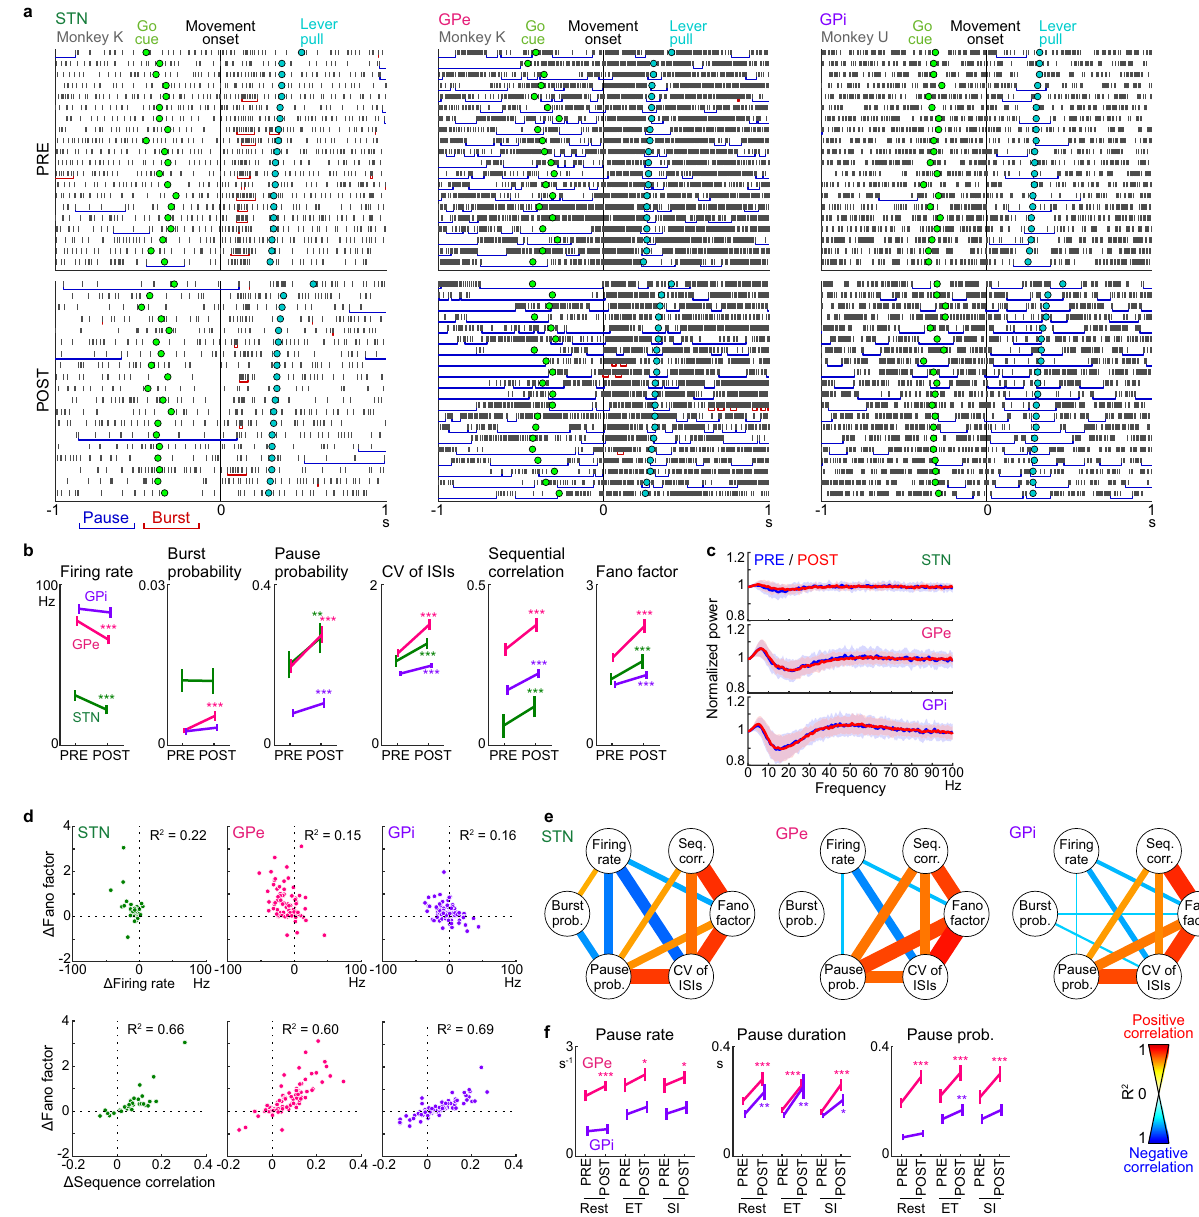
Fig. 4 Firing pattern changes in the STN/GPe/GPi after reduction of STN activity. a Examples of STN/GPe/GPi neuronal activity aligned with Movement onset and sorted by MTs in ET trials during the PRE and POST periods with bursts (red horizontal line) and pauses (blue). b Analyses of spike trains of 37 STN, 78 GPe, and 83 GPi neurons during − 1.0 to 1.0 s relative to Movement onset in both ET and SI trials. Firing rate of STN and GPe neurons decreased ( P = 1 × 10 − 6 and 2 × 10 − 8 , respectively; two-tailed Wilcoxon-signed rank test), while Burst probability of GPe neurons (0.0004), and Pause probability of STN/GPe/GPi neurons (0.004, 1 × 10 − 8 , 0.0001), CV of ISIs of STN/GPe/GPi neurons (0.0001, 1 × 10 − 11 , 6 × 10 − 7 ), Sequential correlation of STN/GPe/ GPi neurons (7 × 10 − 5 , 3 × 10 − 10 , 4 × 10 − 7 ), and Fano factor of STN/GPe/GPi neurons (2 × 10 − 5 , 5 × 10 − 11 , 2 × 10 − 5 ) increased. c Population-averaged power spectrum density (PSD) function. Solid lines and shading indicate means and SD. d Scatter plots representing changes of each neuron (POST – PRE) between Fano factor and Firing rate (above) and Sequential correlation (below). R 2 , squared Pearson correlation. e Network representation for pairwise correlations between spike parameters in b . Width and color of links between nodes represent strength of correlations. f Analysis of pause in 78 GPe and 83 GPi neurons during the 0.5 s preceding Task cue (Rest) and from − 0.2 to 0.3 s relative to Movement onset (ET and SI) in the PRE and POST periods. In the GPe, Pause rate during Rest, ET, and SI ( P = 5 × 10 − 5 , 0.02, 0.01; two-tailed Wilcoxon-signed rank test), Pause duration during Rest, ET, and SI (1 × 10 − 6 , 1 × 10 − 7 , 5 × 10 − 7 ), and Pause probability during Rest, ET, and SI (2 × 10 − 7 , 2 × 10 − 6 , 4 × 10 − 7 ) increased. In the GPi, Pause duration during Rest, ET, and SI (0.007, 0.008, 0.02) and Pause probability during ET (0.01) increased. Error bars indicate SEM. * P < 0.05, ** P < 0.01, *** P <